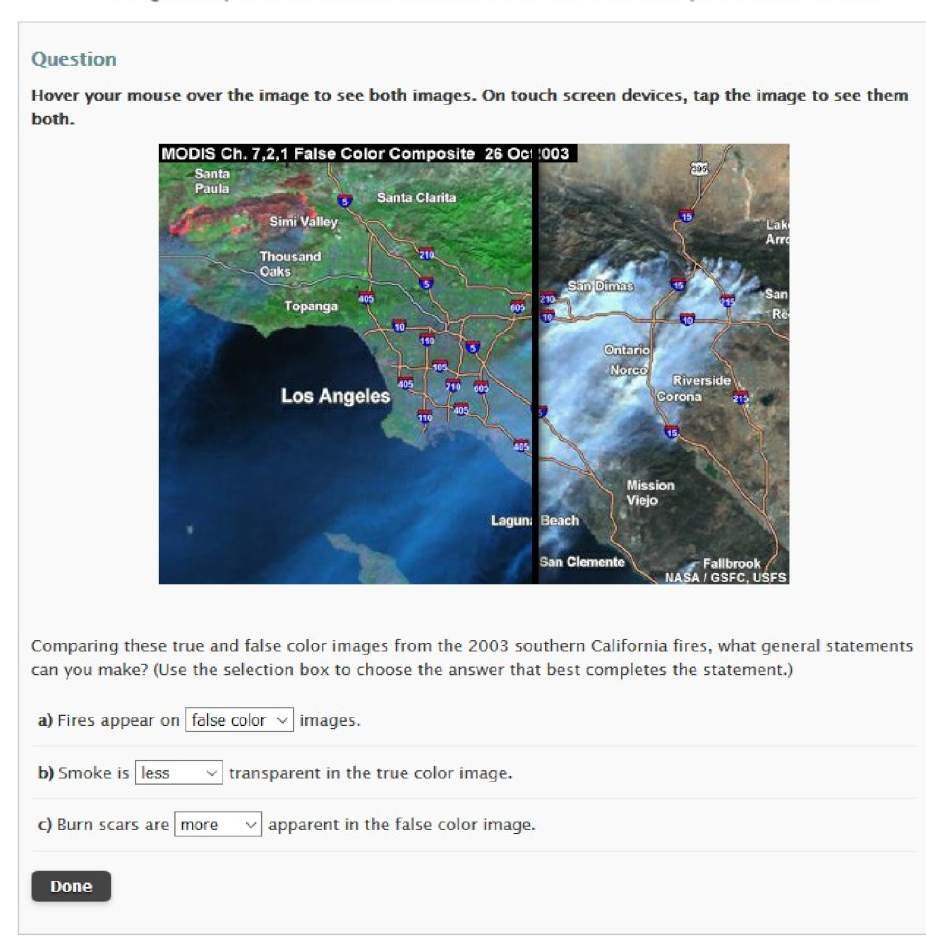
Figure 6. An interactive slider tool lets learners compare imagery products as they answer